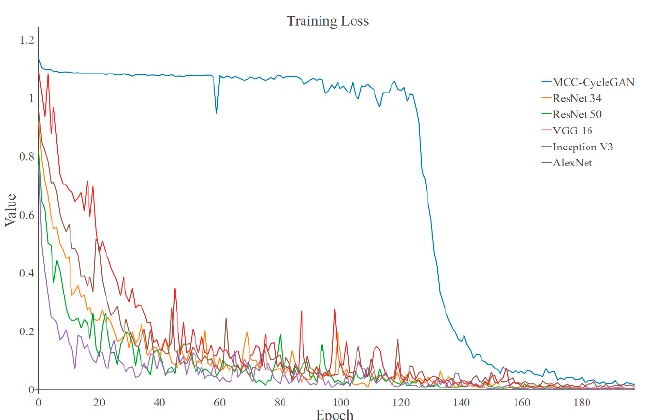
Figure 6. The training losses of the MCC-CycleGAN and other classical algorithms. The loss of proposed MCC-CycleGAN fluctuates around 1.1 and makes no progress, and losses of other contrastive algorithms decrease fast. At the end of training, losses of all networks stay stable and tend to be zero.